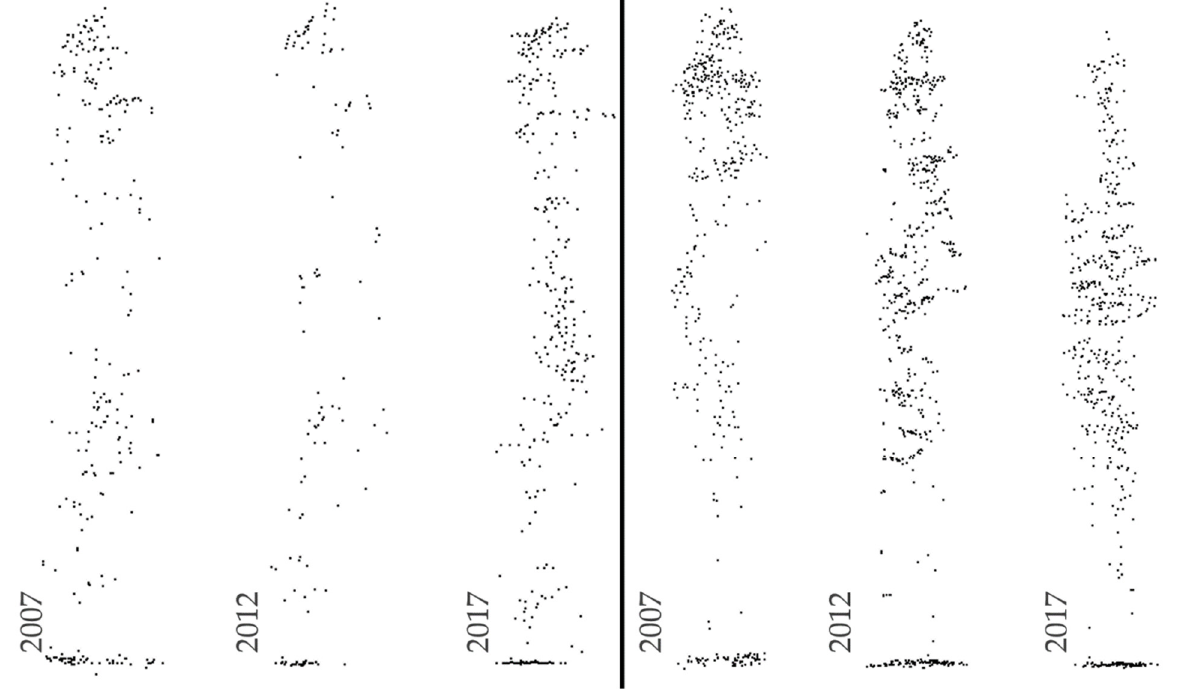
Figure 9. Examples of trees with negative height increment in the period 2007–2017: left—due to terminal stage and tip bending, right—due to tree dying.